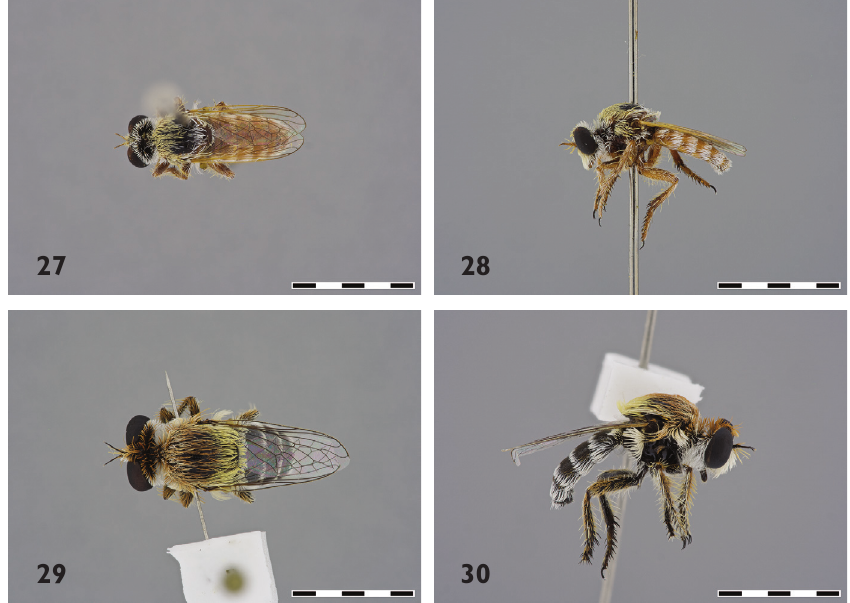
Figures 27–30. Photographs of Willistonininae: 27 female Astiptomyia bikos Londt, 2010 (NMSA- DIP-66454), dorsal (Morphbank #860701) 28 same, lateral (#860704) 29 female Sisyrnodytes subater Oldroyd, 1957 (USNMENT00870084), dorsal (#860710) 30 same, lateral (#860712). Scale bars: 5 mm.